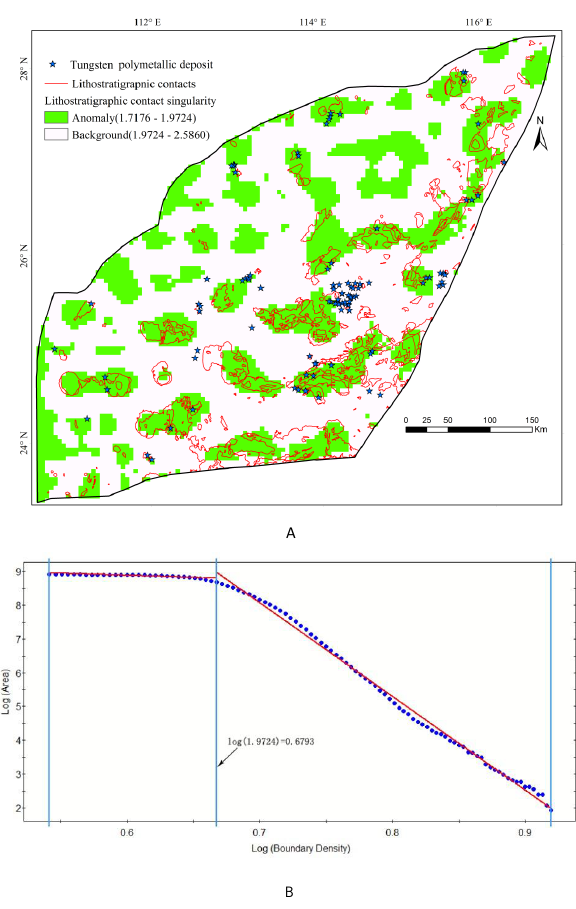
Fig.3. (A) Map showing the Yanshanian granitic contacts density singularity, and (B) Log–log plots for the Yanshanian granitic contacts.